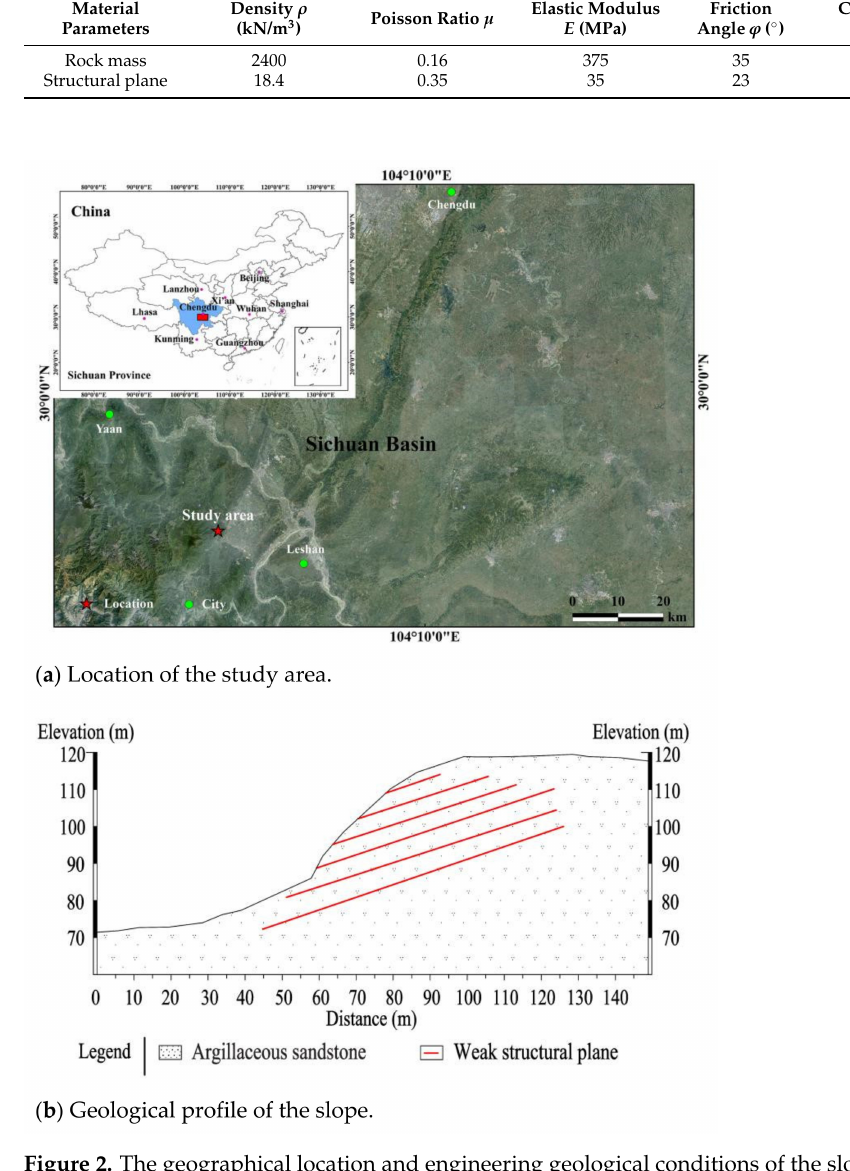
Figure 2. The geographical location and engineering geological conditions of the